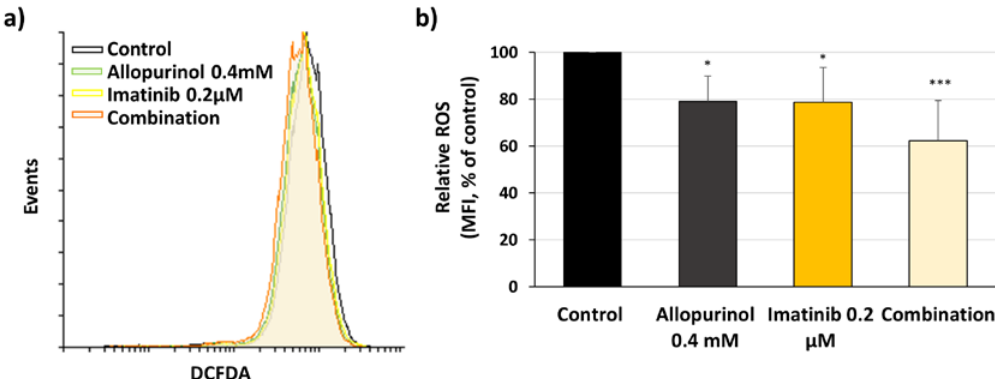
Figure 7. Imatinib, allopurinol, and their combination reduce intracellular reactive oxygen species (ROS) levels. K562 cells were treated with 0.2 μM imatinib, 0.4 mM allopurinol or their combination for 6 h. Intracellular ROS levels were analyzed by flow cytometry staining with 2′ , 7′ -dichlorofluorescein diacetate (DCFDA). ( a ) A representative flow cytometry histogram is shown. ( b ) DCFDA mean fluorescence intensity with respect to control reflecting intracellular ROS levels is shown ( n = 8). *** p < 0.001, * p < 0.05 reflects significant differences with respect to control.